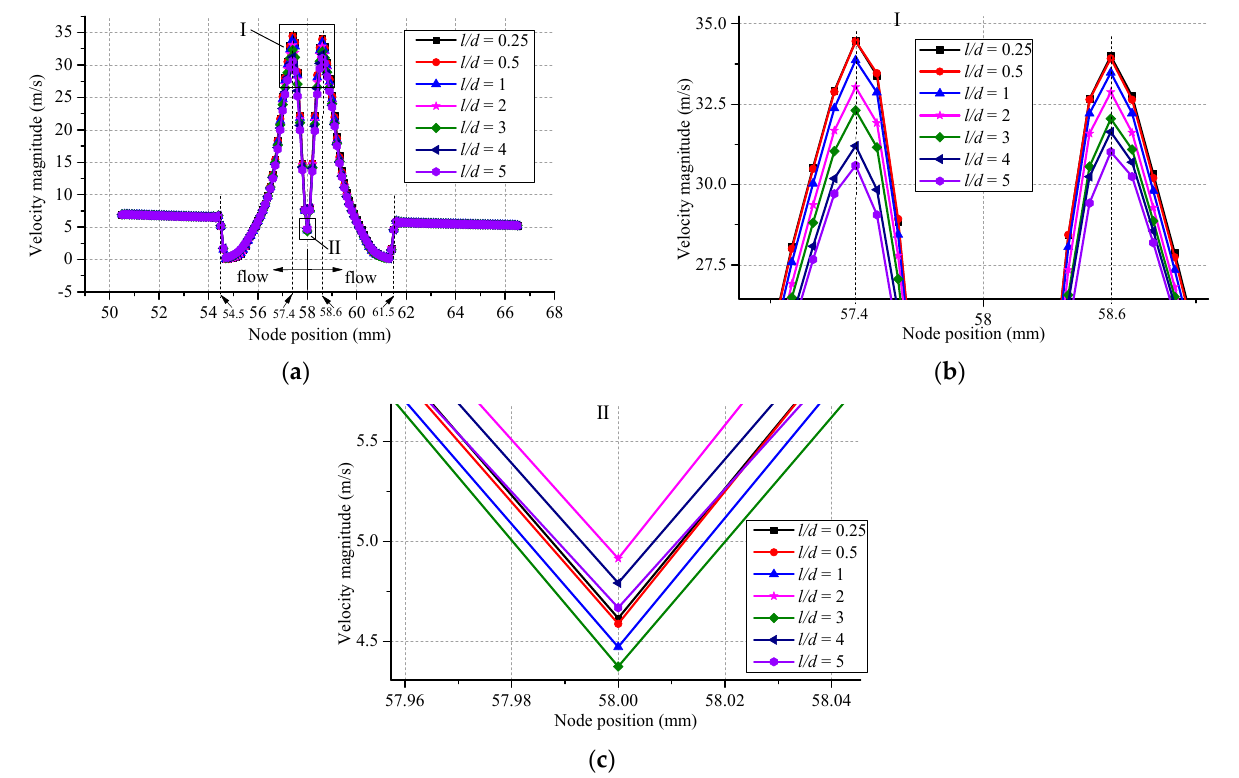
Figure 8. Velocity magnitude patterns of various OLDRs along the line of b 1 – b 2 . ( a ) Velocity magnitudes of various OLDRs along the line of b 1 – b 2 ; ( b ) local enlarged view of Ⅰ ; ( c ) local enlarged view of Ⅱ